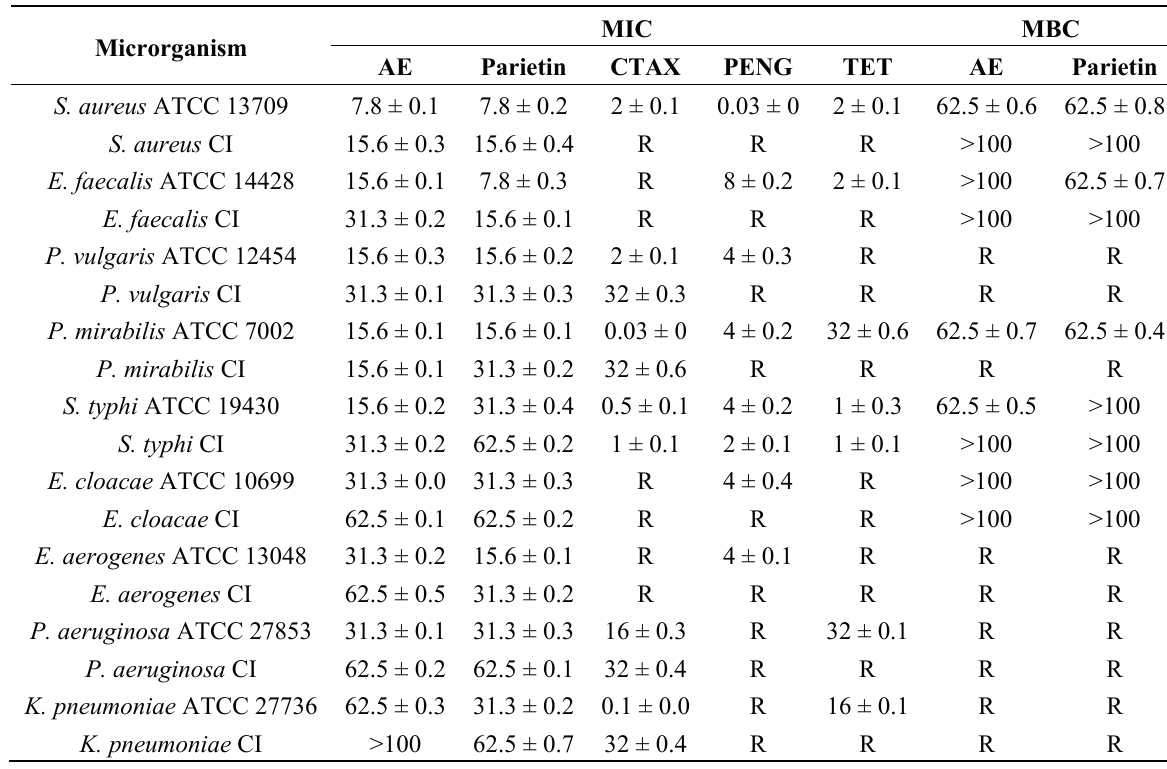
Table 1. Minimal inhibitory concentration (MIC) and minimum bactericidal concentration (MBC) values ( μ g/mL) of acetone extract (AE) from Xanthoria parietina and parietin, and MICs of reference antibiotics.